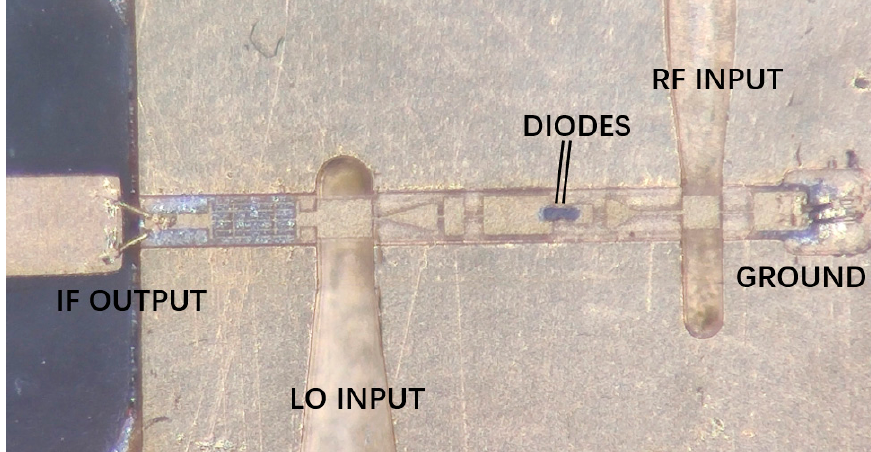
Figure 9. The photo of the sub-harmonic mixer mounted in block.